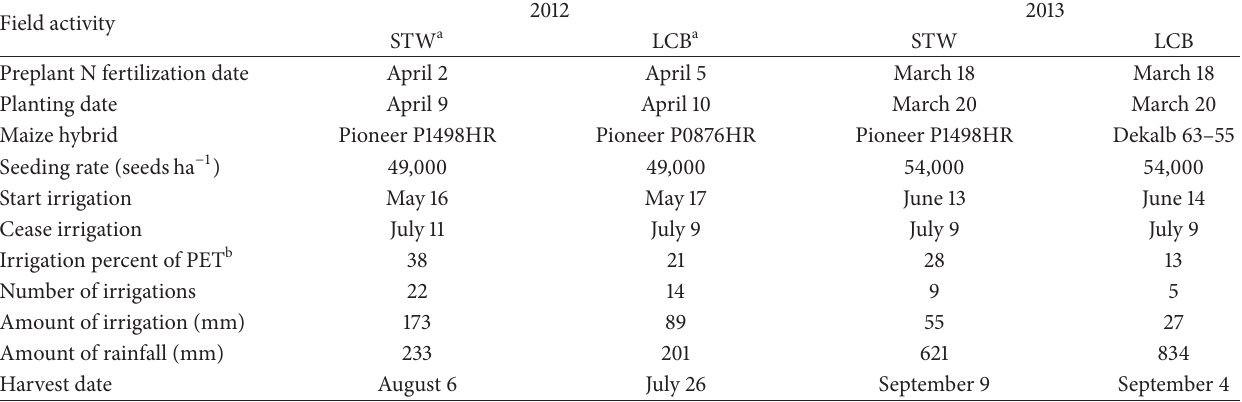
Table 3: Field activities for the four site-years utilized in this study.